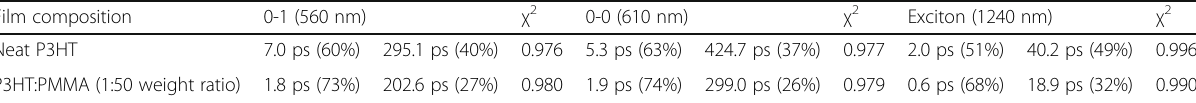
Table 1 Decay time constants and amplitudes of TA spectra of P3HT and P3HT:PMMA films in the GSB and exciton regions; the dynamics is fitted by two-exponential decay OD ( t ) = A 1 exp ( − t/t 1 ) + A 2 exp ( − t/t 2 ) Film composition 0-1 (560